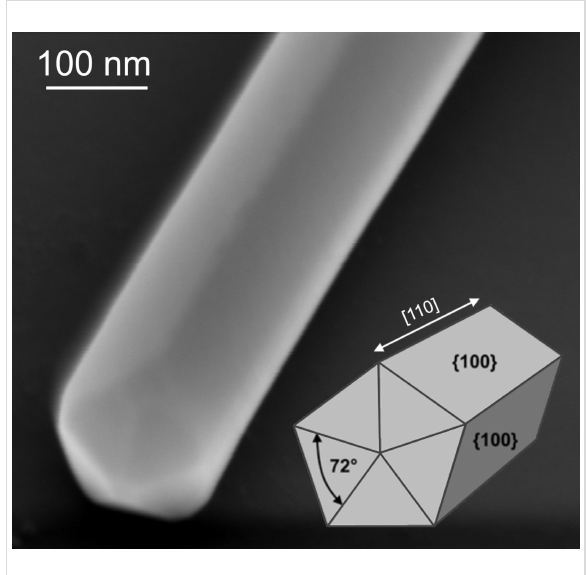
Figure 1: Schematic and SEM image of a pentagonal silver nanowire (Ag NW). SEM image adapted with permission from [28], copyright 2013